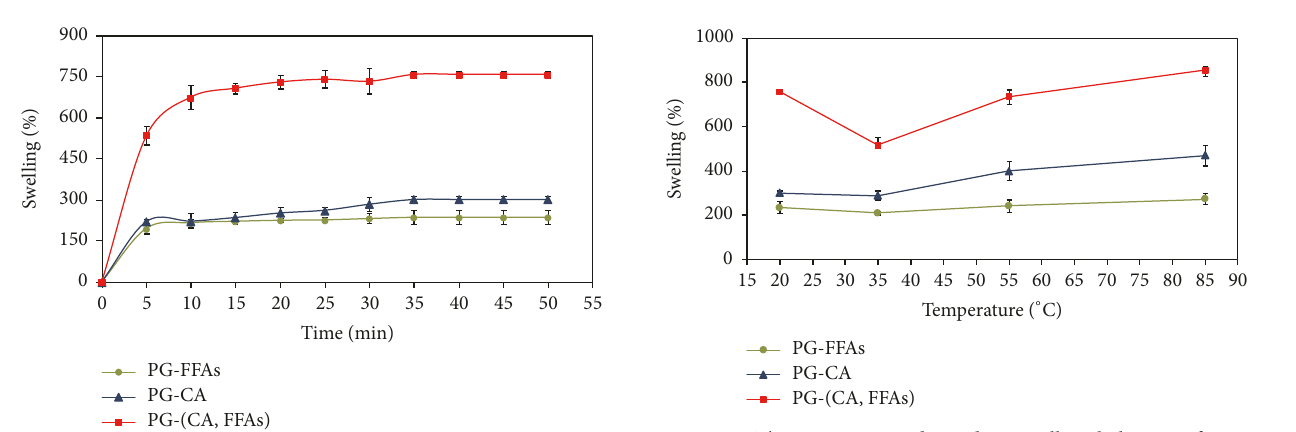
Figure 8: The temperature-dependent swelling behavior of treat- ments PG-FFAs ( e ), PG-CA ( 󳵳 ) and PG-(CA, FFAs) ( ◼ ). Swelling percentage was calculated using